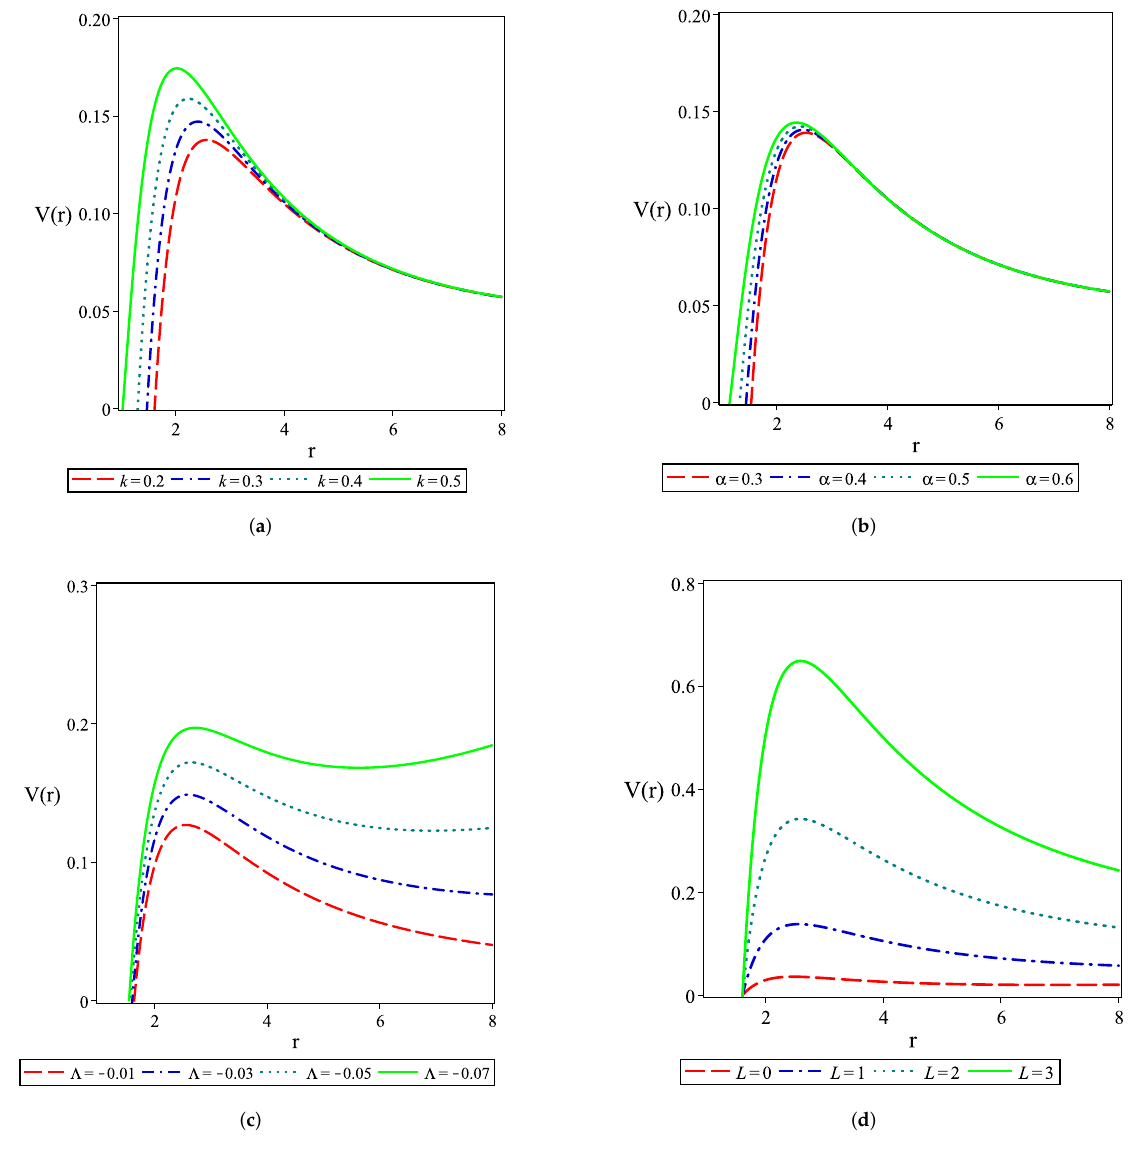
Figure 4. The effective potential for the specific case of M = 1 and different values of k (Figure 4a), α (Figure 4b), Λ (Figure 4c) and L (Figure 4d). See the text for more details. ( a ) α = 0.2, l = 1 and Λ = − 0.02; ( b ) k = 0.2, l = 1 and Λ = − 0.02; ( c ) k = α = 0.2 and l = 1; ( d ) k = α = 0.2 and Λ = −